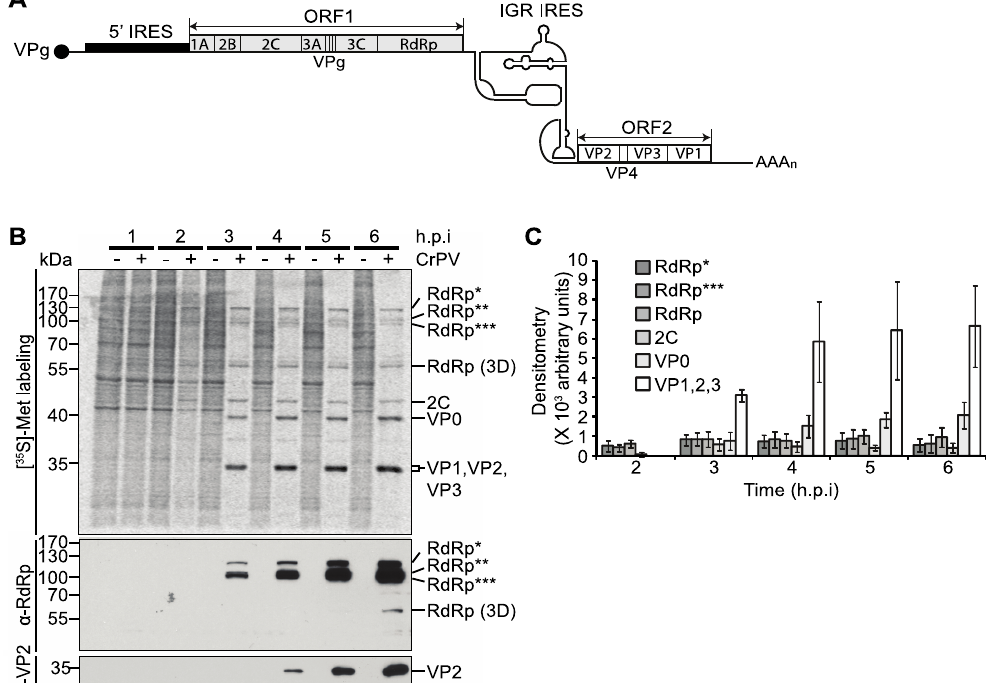
Figure 1. Viral non-structural and structural protein expression in CrPV-infected S2 cells. ( A ) Schematic of the genome arrangement of CrPV; ( B ) Autoradiography of pulse-labelled protein lysates from S2 cells either mock- or CrPV-infected (MOI 10) resolved on a 12% SDS-PAGE gel. The protein lysates were collected from S2 cells at the indicated times hours post-infection (h.p.i.) and metabolically labelled with [ 35 S]-Met/Cys for twenty minutes at the end of each time point (top). The identities of specific CrPV viral proteins, as shown on the right of the gel, were previously described [7,8] and determined by immunoblotting with α -RdRp and α -VP2 peptide antibodies or predicted by molecular weight (below); ( C ) Raw densitometric quantitation of [ 35 S]-Met/Cys pulse-labelled RdRp*, RdRp**, RdRp***, 2C, VP0, and VP1, 2, and 3 during CrPV infection from three independent experiments (±s.d.). RdRp*, RdRp**, and RdRp*** denote polyproteins containing RdRp at the approximate sizes of 120 kDa, 105 kDa, and 100 kDa respectively.